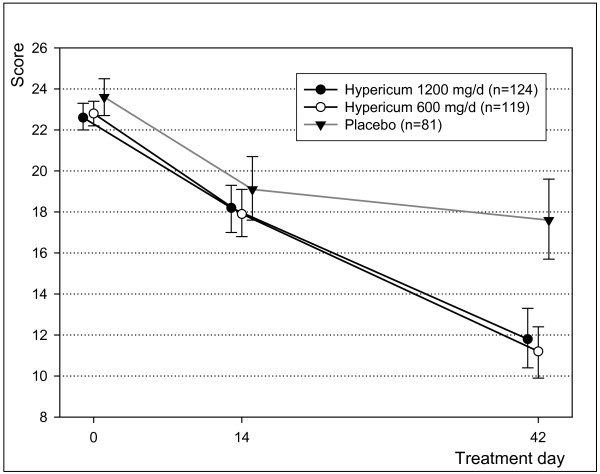
Change in mean total HAM-D score in patients suffering a major depressive episode over the 6-week treatment with WS® 5570 or placebo (full analysis set, means and 95% confidence intervals).